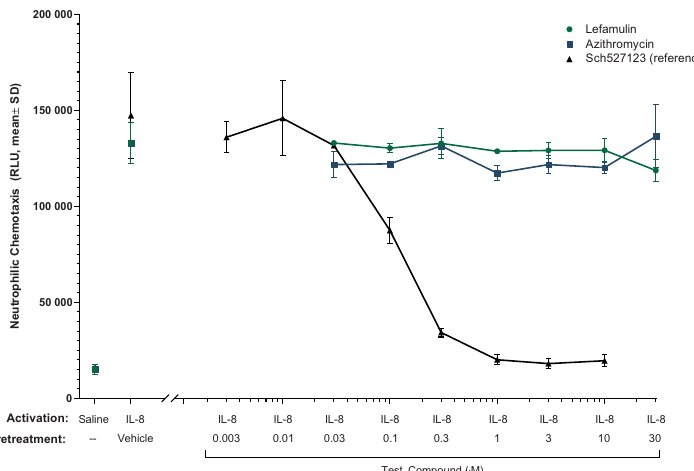
Fig 3. Chemotaxis of IL-8–activated human neutrophils with lefamulin, azithromycin, and Sch527123 (reference compound). IL, interleukin; RLU, relative light unit; SD, standard deviation.